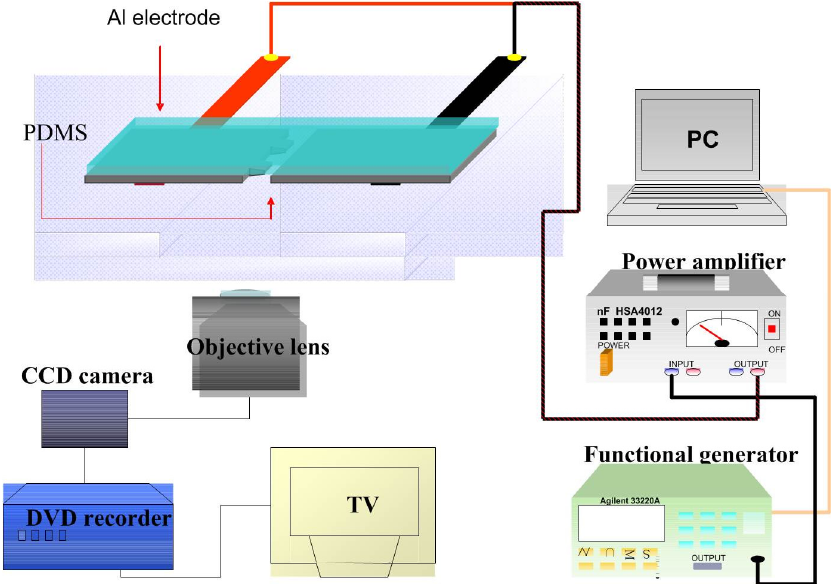
Figure 1. The scheme of dielectrophoresis (DEP) force measurement system for determining the cell adhesion strength of ECV304 on COL1 or FN coated PDMS membrane. The electrophoresis force is produced by the driving voltage of electrodes.